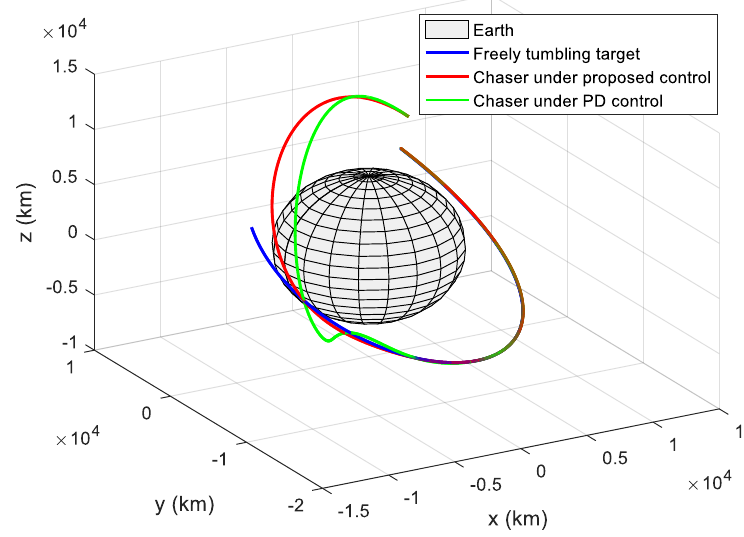
Figure 3. Translational motion of the chaser and the target for proximity operation.